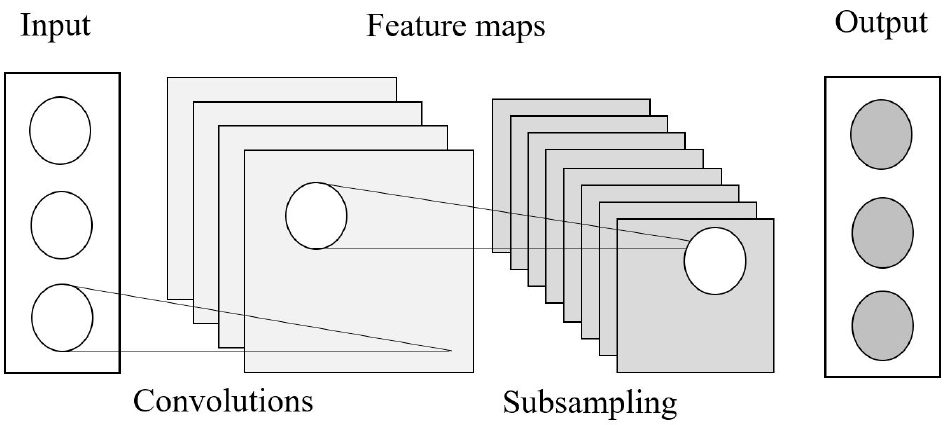
Figure 2. Structure of the 1D convolutional neural network (CNN) for text classification.